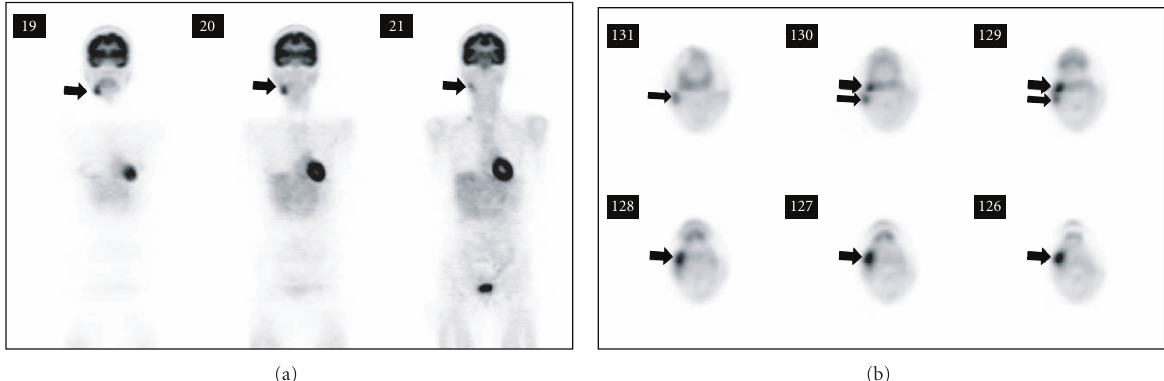
Figure 2: FDG-PET images of Case 2. (a) Intense uptake (SUV: 6.24) in the right submandibular gland (arrows). (b) Intense uptake in the right submandibular gland (thick arrows) and the deep interior cervical area (thin arrows).